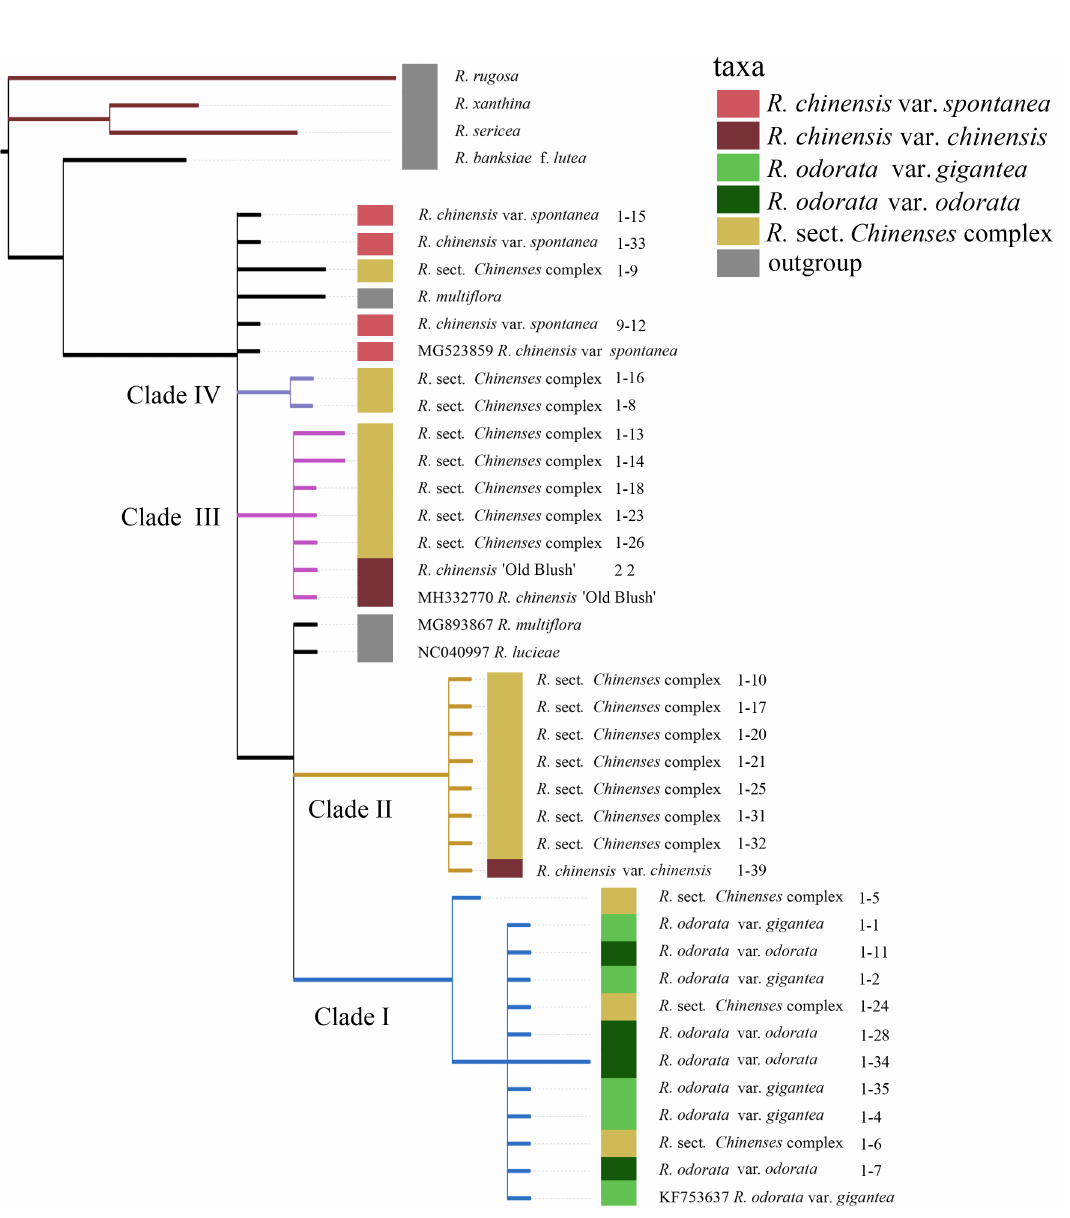
Figure 7. Phylogenetic analysis of R . sect. Chinenses based on chloroplast